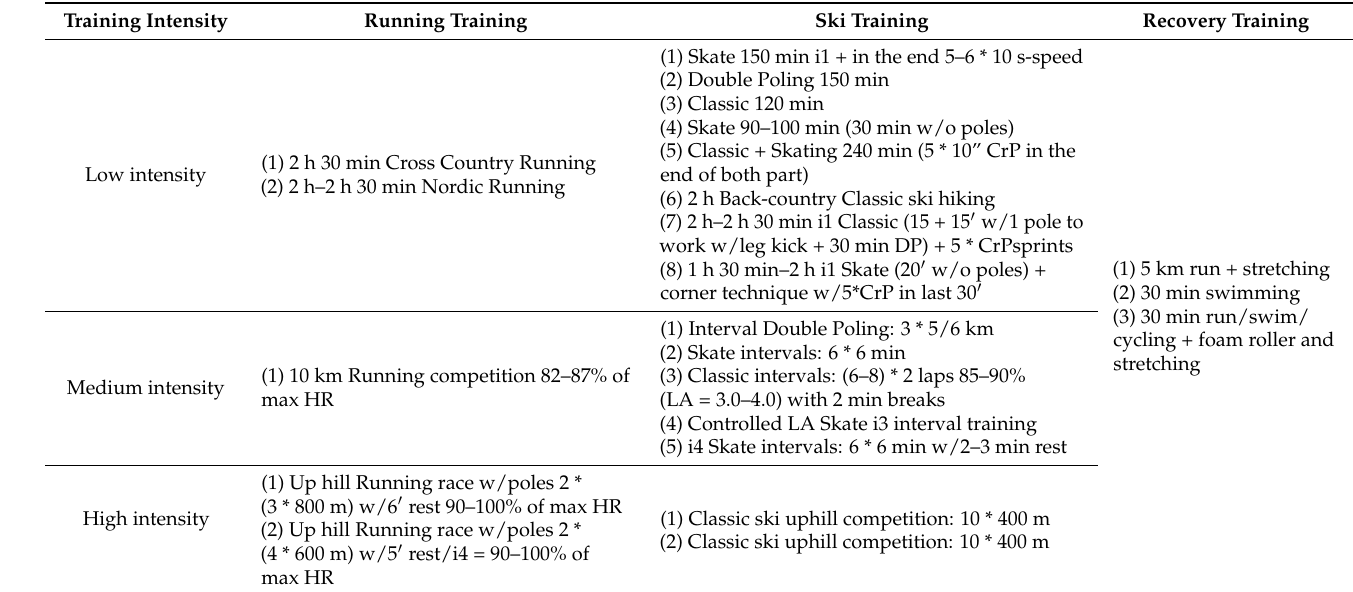
Table 4. Special training content and load of cross-country